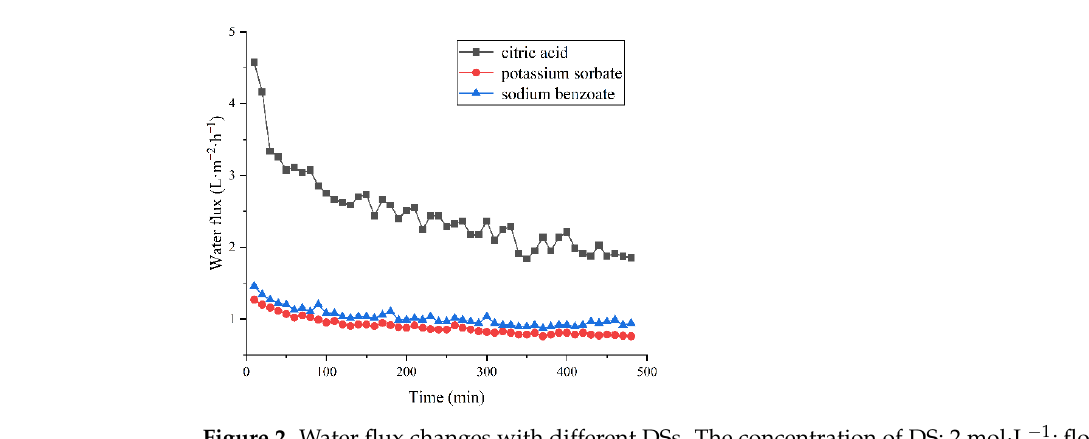
Figure 2. Water flux changes with different DSs. The concentration of DS: 2 mol·L − 1 ; flow rate on both sides: 120 mL·min − 1 ; membrane orientation: active layer towards the feed.